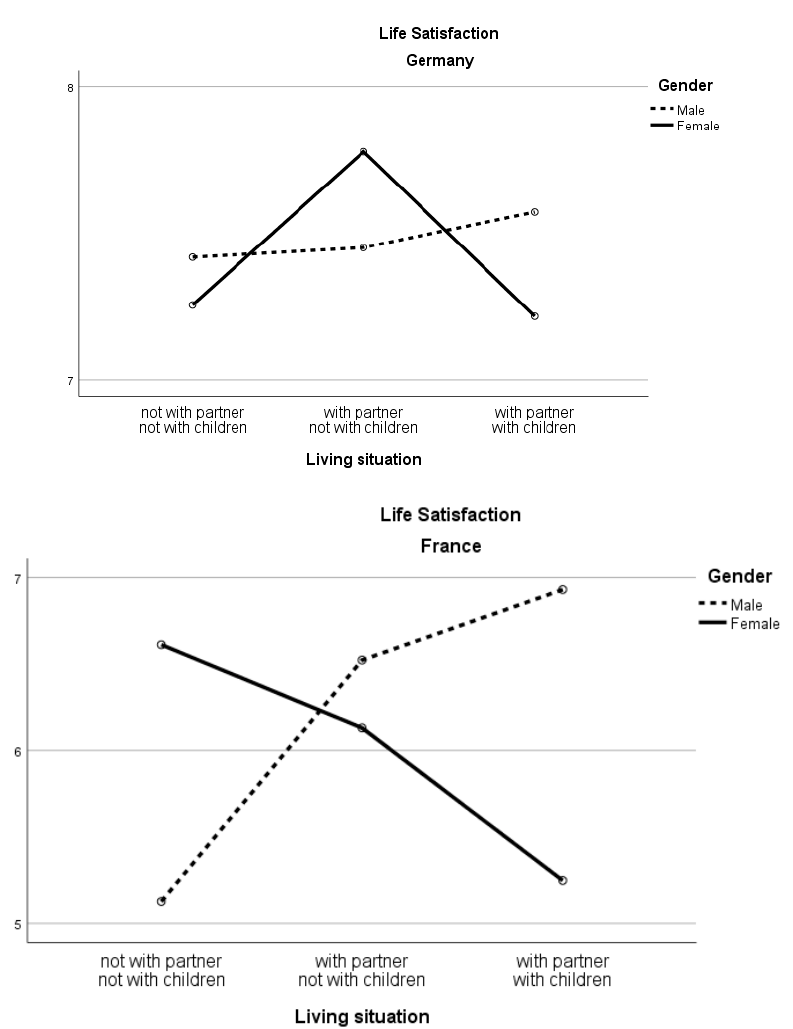
Figure 3. Three-way interaction between gender, country and home for life satisfaction.